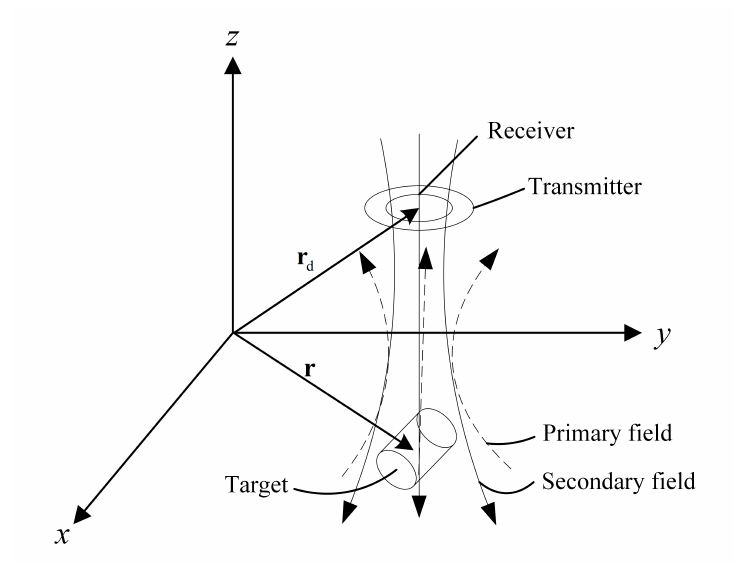
Figure 2. Primary field model in spherical coordinates.